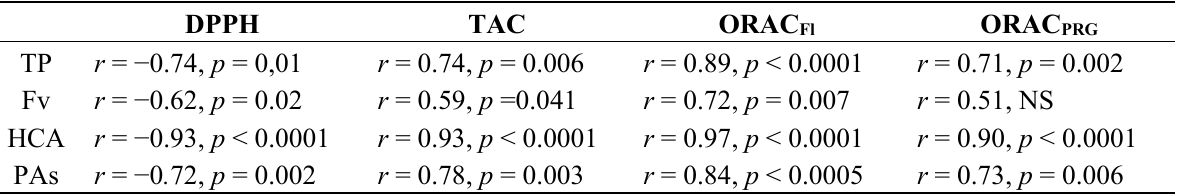
Table 3. Spearman’s correlation coefficients obtained between antioxidant activities and the polyphenolic composition of M. arboreus extracts. DPPH TAC ORAC